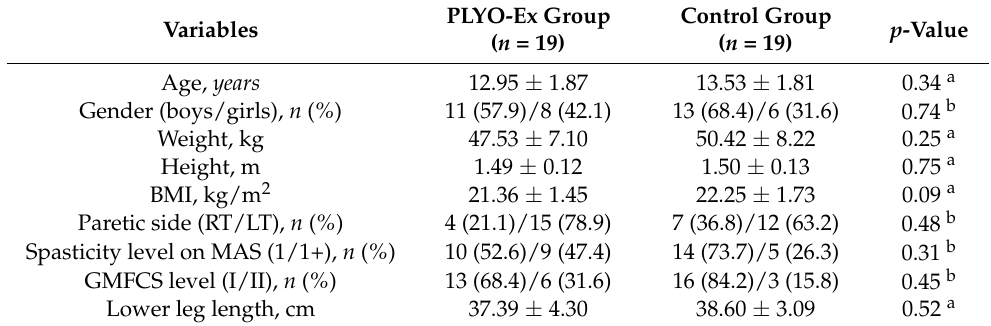
Table 1. Baseline characteristics of the participating children in the PLYO-Ex and control group.